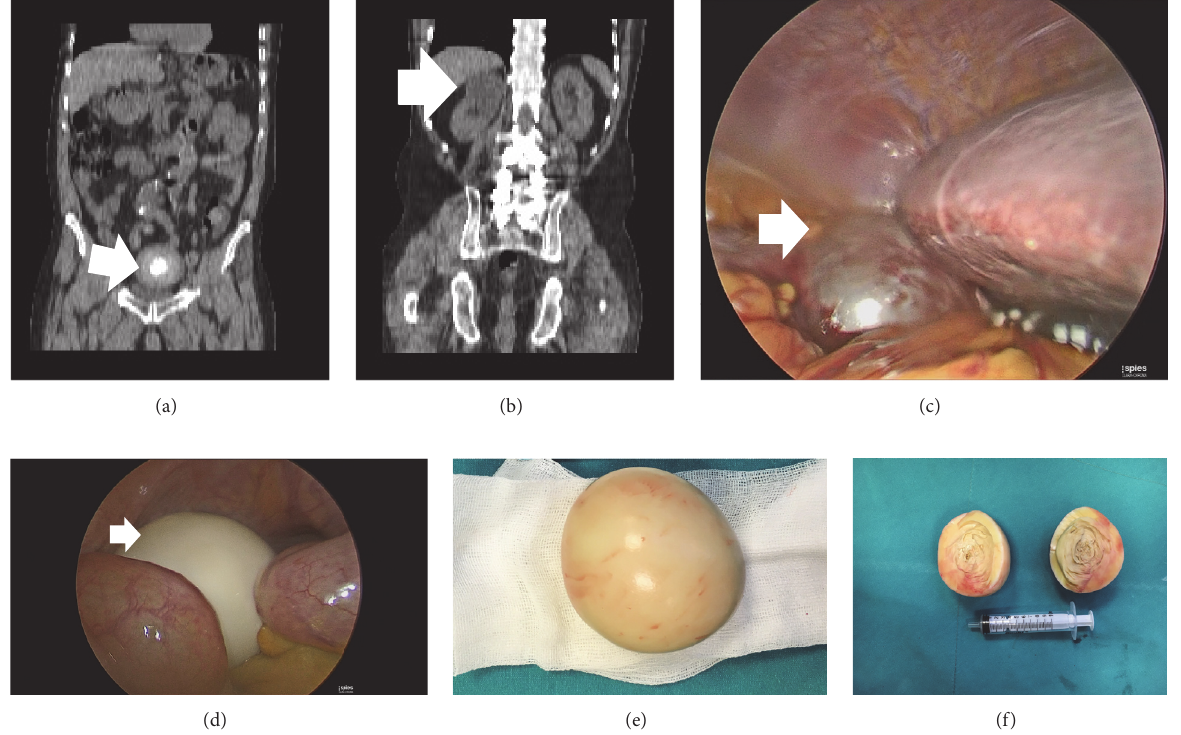
Figure 1: The calcific mass floating independently in abdomen and right kidney mass were diagnosed. (a) Computed tomography revealed a calcific mass with 7cm diameter that was making pressure on bladder. (b) There was right kidney cyst with 5.3 cm diameter on the upper pole in computed tomography scan. (c) The kidney cyst was decorticated during laparoscopic surgery. (d) The free mass was observed simultaneously in laparoscopic surgery. (e) The mass was taken out directly; there was no attachment around other tissues. (f) The mass was divided into half; it was very